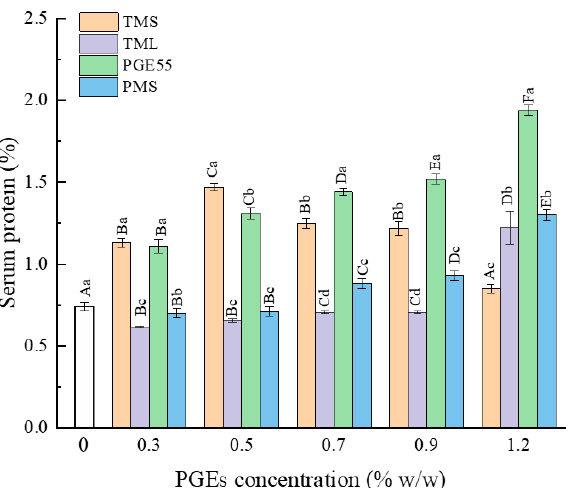
Figure 6. Effect of different PGEs on serum protein content. Uppercase letters indicate differences between concentrations, and lowercase letters indicate differences between PGEs.